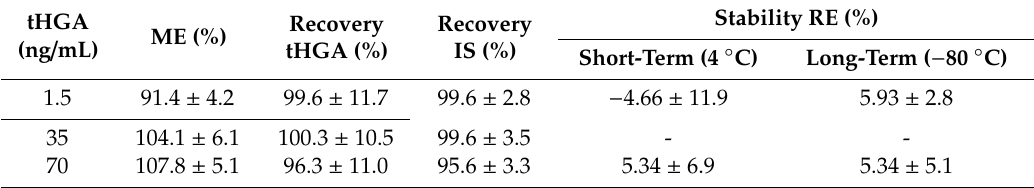
Table 2. The matrix e ff ect, recovery, and stability of tHGA in rat plasma (n =